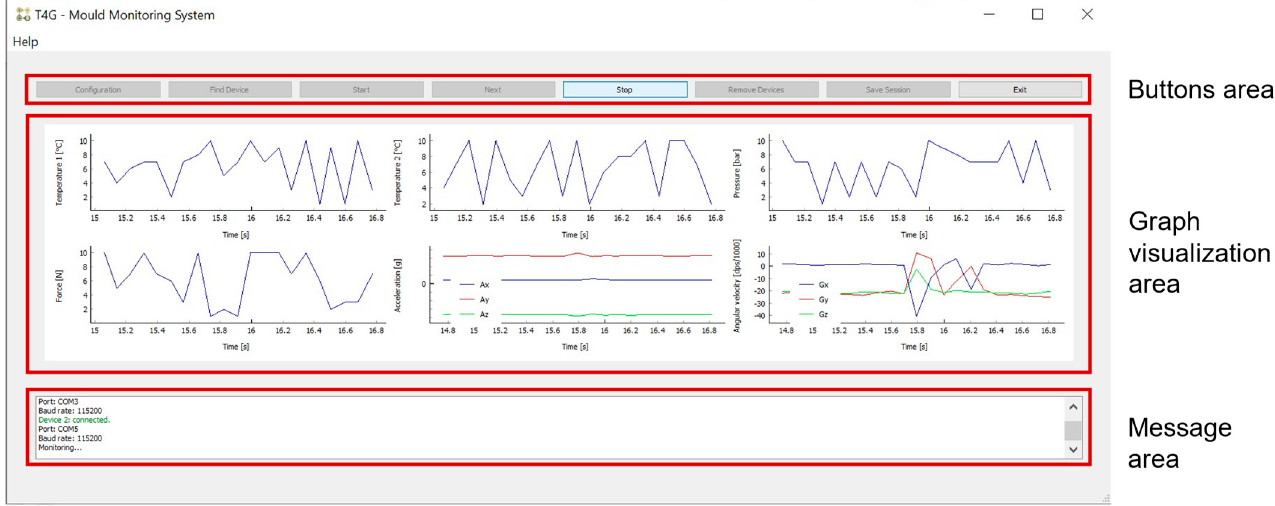
Figure 4. Main window during a monitoring session, with the main zones identi fi ed and high- lighted.